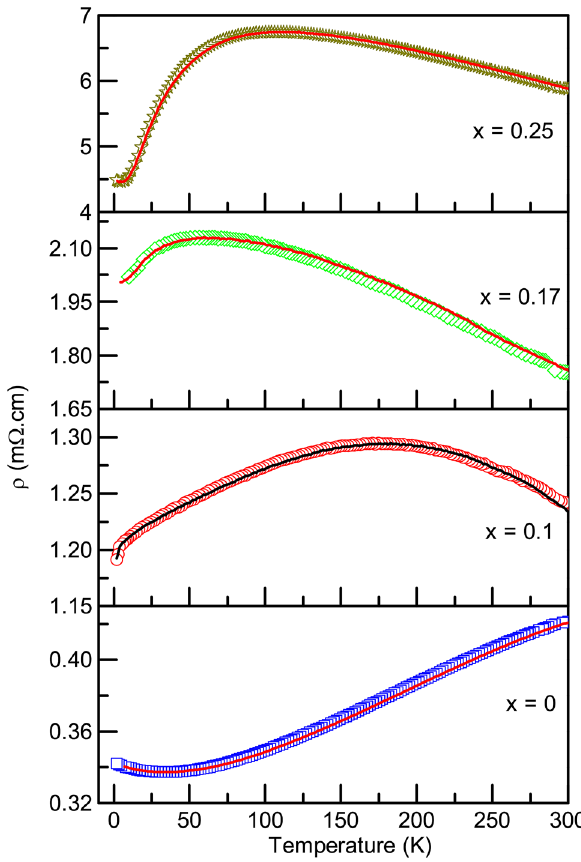
Cr x x Sn, recorded −